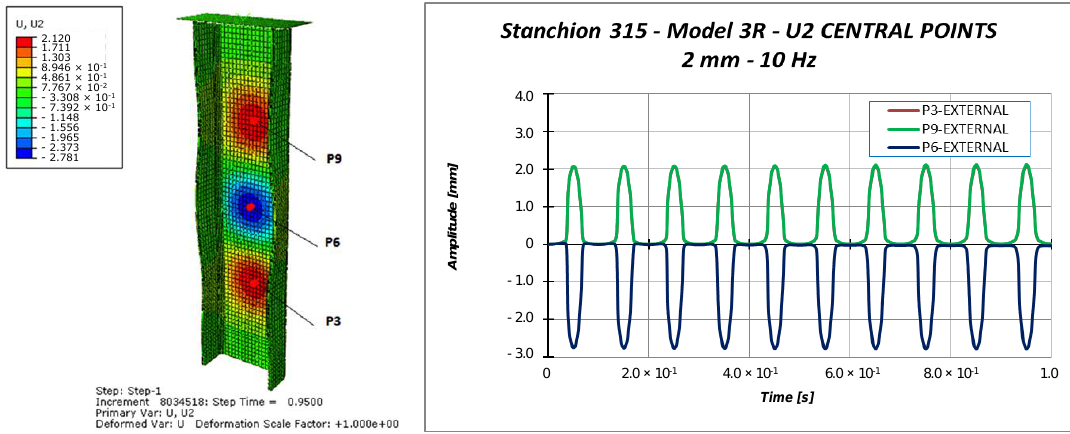
Figure 20. Out-of-plane displacement: 2.0 mm applied displacement.